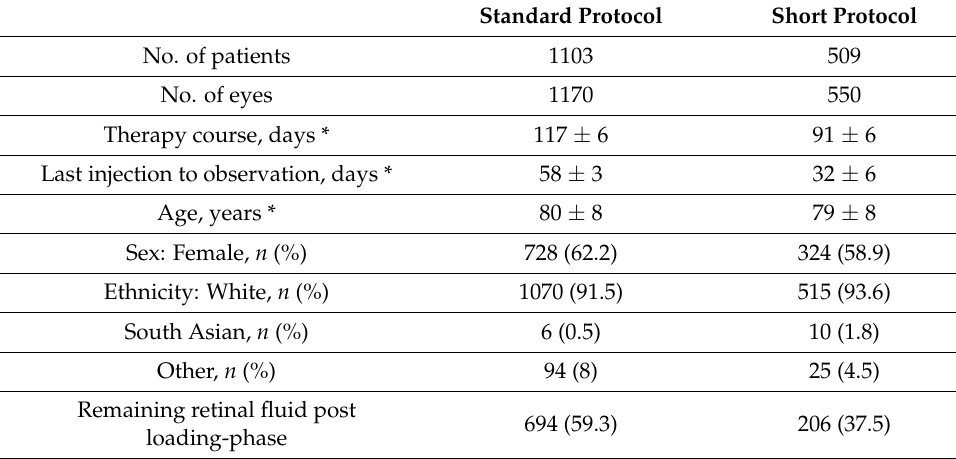
Table 1. Patient characteristics for standard and short protocols. Standard Protocol Short Protocol